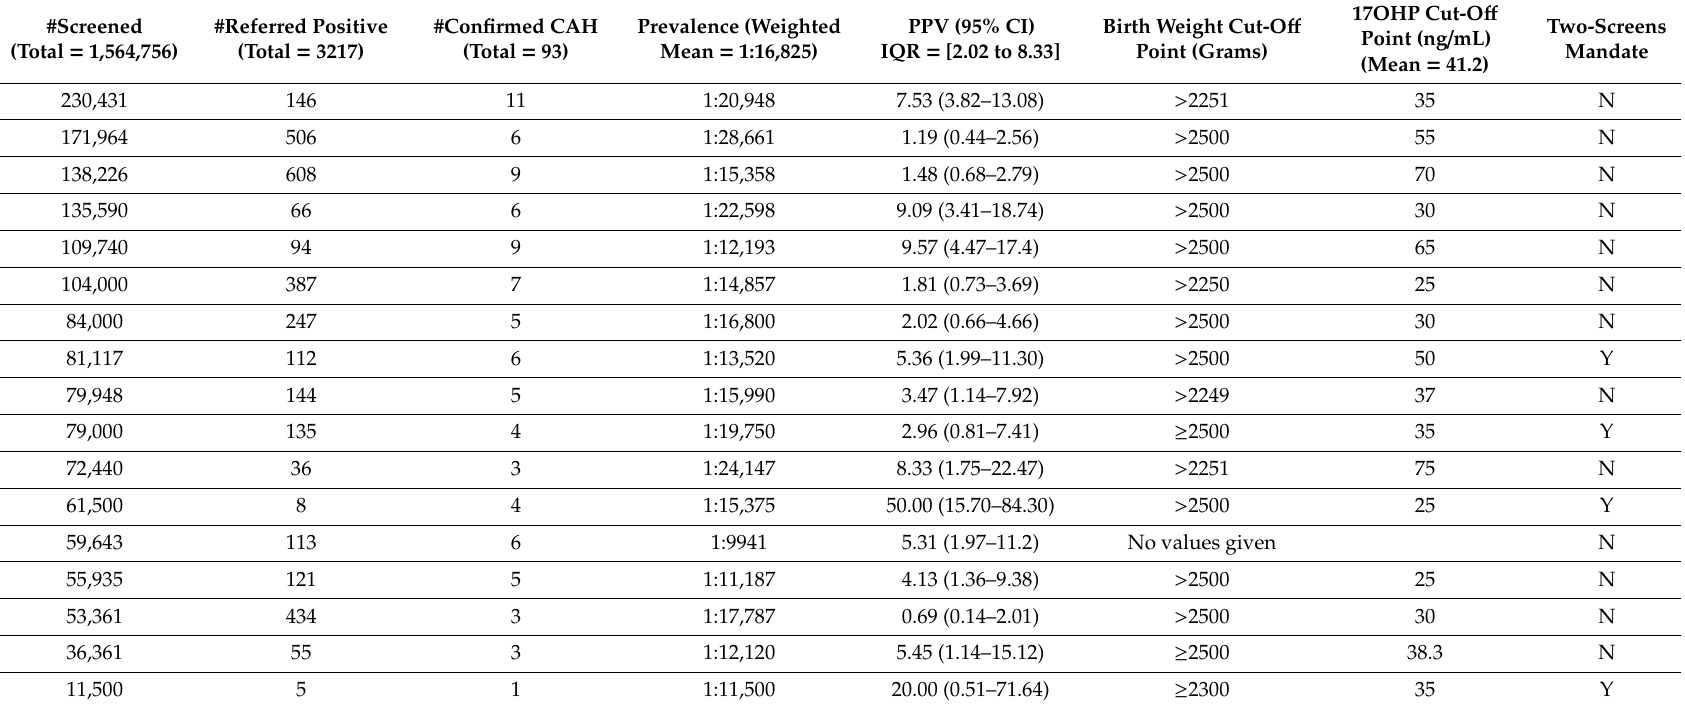
Table 1. CAH newborn screening by